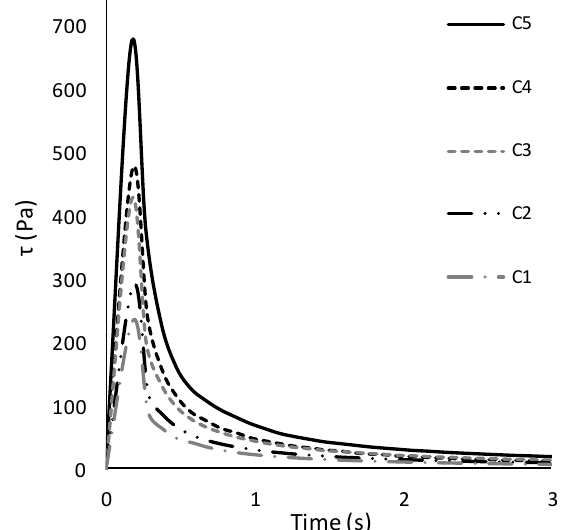
Figure 2. Stress overshoot curves (average of three replications) of chocolate creams differing in solid concentrations (C1, 31%, C2, 33%, C3, 36%, C4, 39%, C5, 43%, ( w/v )). As expected, by increasing the solid concentration, the maximum shear stress value (stress overshoot, Pa) increased accordingly. In addition, the values of the stress overshoot of each sample were extrapolated from each curve and reported as the representative parameter of the flowability of the tested creams. The trend in the stress overshoot was described with a linear equation ( R 2 = 0.98). The stress overshoot values were significantly different (Duncan’s test, p < 0.0001).